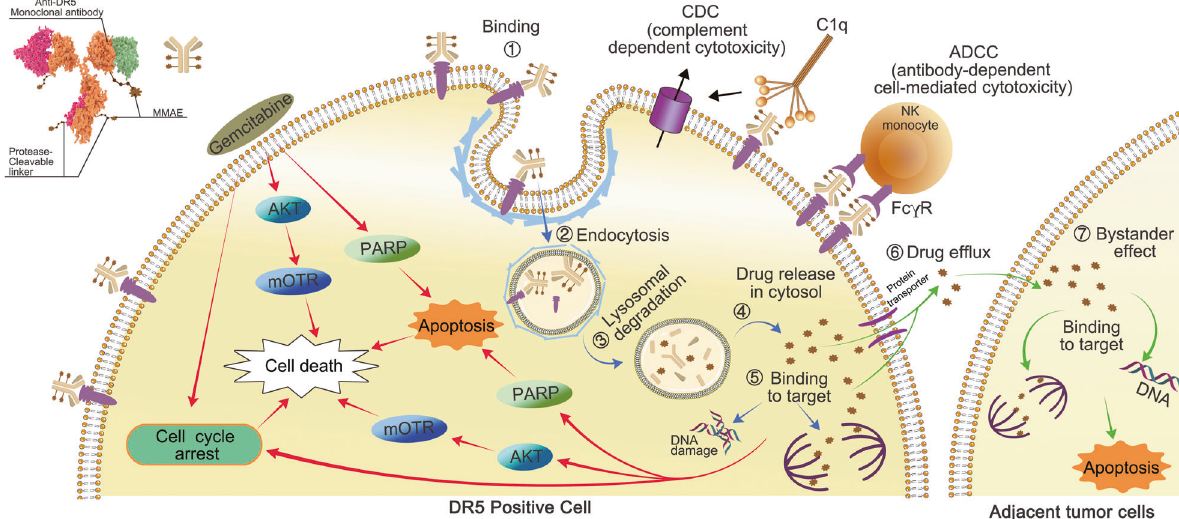
Fig. 8 Action mechanism of Oba01. Upon binding to DR5 on the cell surface, Oba01 exerted cytotoxicity through three mechanisms: (1) as indicated by blue arrows, Oba01 is internalized via endocytosis and translocated into lysosome where the MMAE moiety is cleaved off the antibody by proteases, resulting in its release into the cytosol to induce cell apoptosis through DNA damage or microtubule disruption; (2) as indicated by green arrows, cytotoxic MMAEs diffused out of the target tumor cells to kill the neighboring tumor cells that may or may not express DR5, a process known as the “ bystander effect ” ; 3) the antibody moiety of Oba01 promotes natural antitumor immune response mechanisms, such as ADCC and CDC for additional cytotoxicity. As indicated by red arrows, the cytotoxicity of Oba01 is synergistically enhanced when combined with gemcitabine, as both drugs can activate PARP-dependent apoptosis and inhibit pro-mitogenic and pro- survival pathways, such as the PI3K/mTOR-signaling cascade. Gemcitabine can also activate cell apoptosis by inducing DNA damage. Therefore, the combined therapy of Oba01 and gemcitabine could signi fi cantly augment PC cell